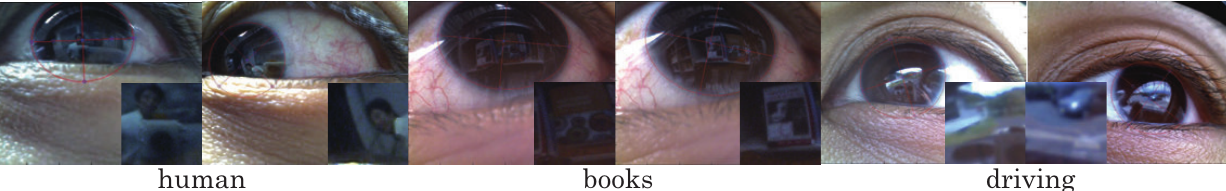
Ohno, T. (2006). One-point calibration gaze tracking method. In Proceedings of the 2006 symposium on eye tracking research & applications (pp.